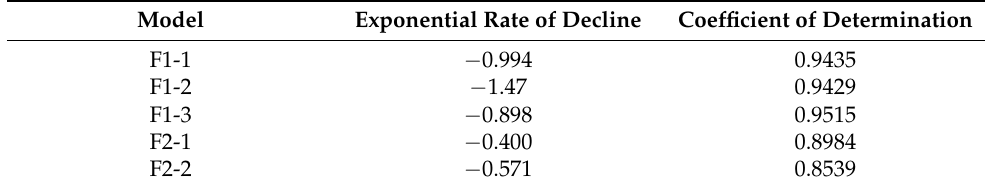
Figure 8. Trends of normalized electrical resistance for different percentages of fiber content. Table 3. Regression results for surface electrical